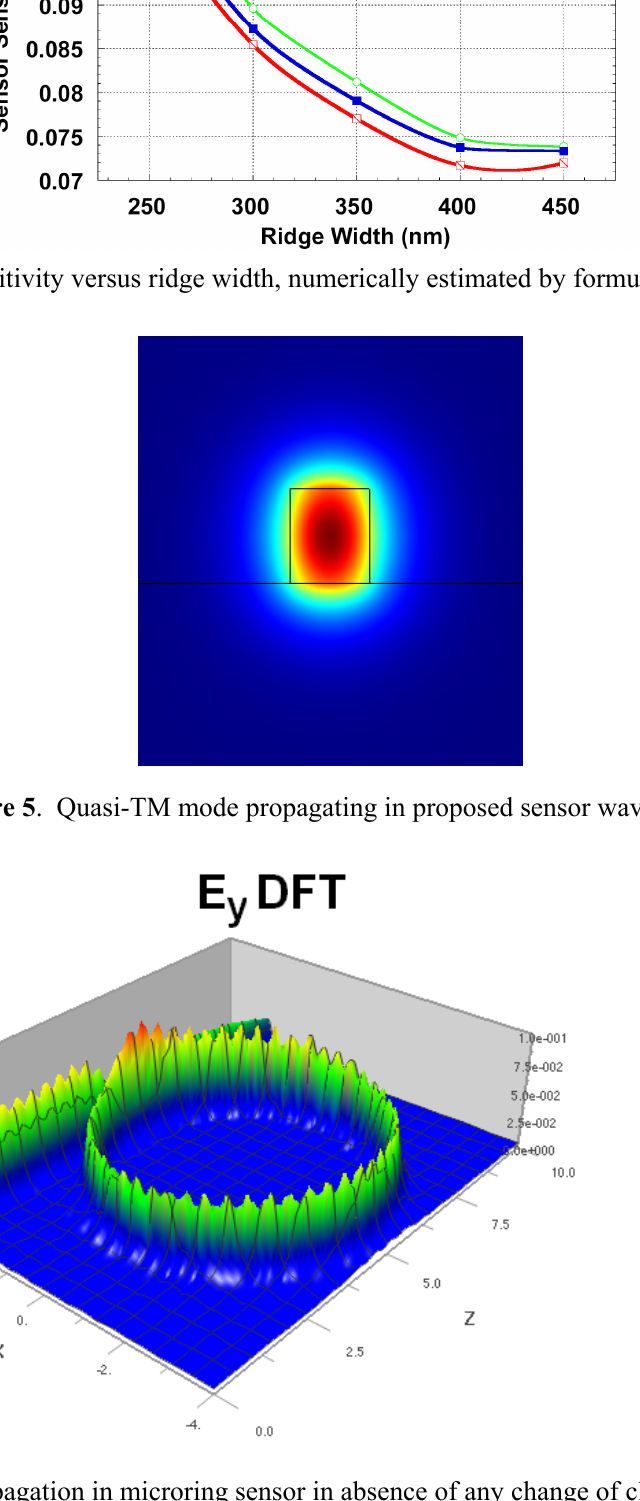
Figure 6 . Optical propagation in microring sensor in absence of any change of cladding refractive